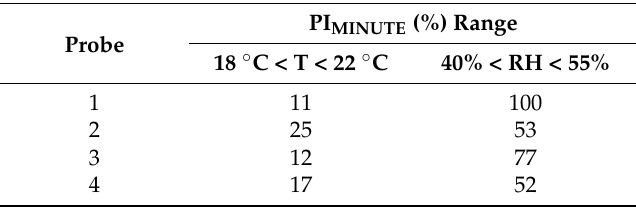
Table 3. Performance Index calculated as the percentage of values of temperature and relative humidity (PI MINUTE(range) ) that fall inside the range recommended in the UNI 10829:1999 standard for the conservation of objects made of